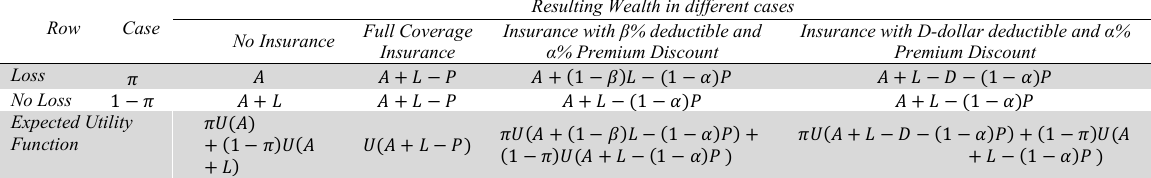
Different decisions for buying insurance and their